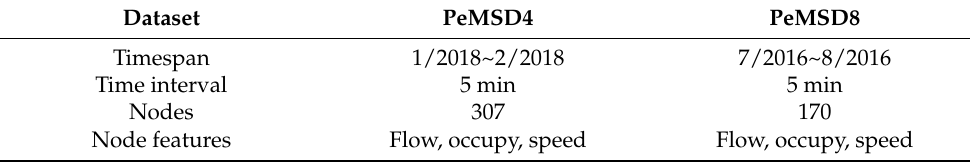
Table 1. Details of the